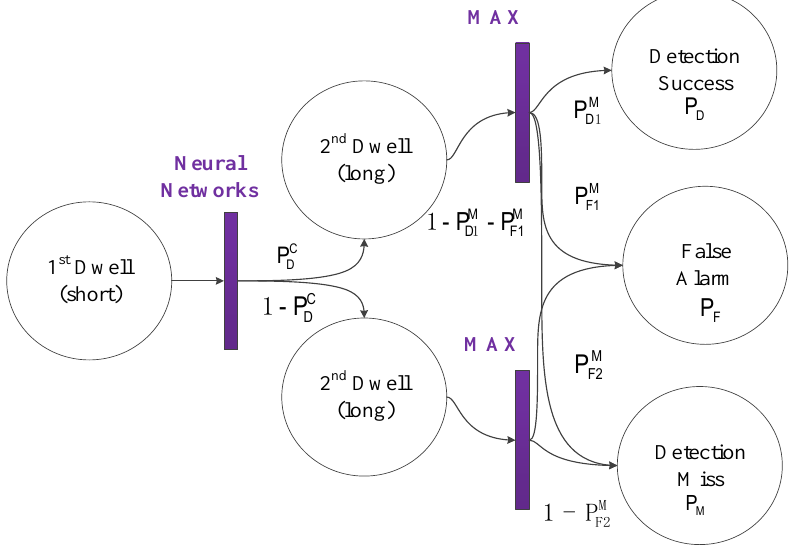
Figure 3. Double dwell/correlation envelope identification (DD/CEI) conditional probability graph.